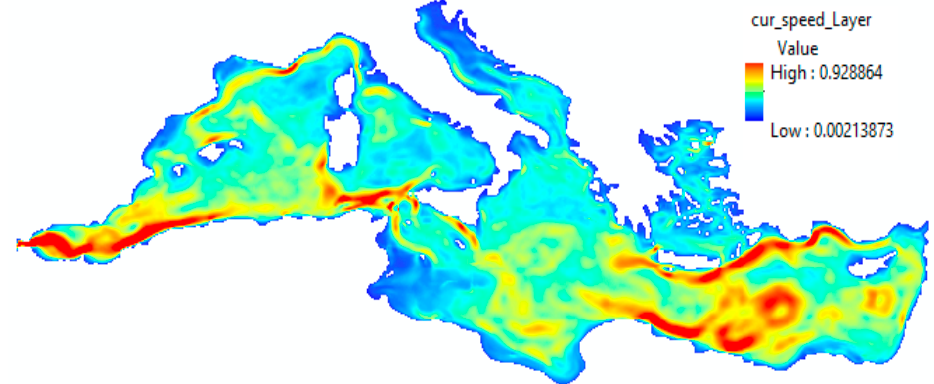
Figure 5. Sea current speed (SCS) (maximum speed over layer depth) averaged with 10 m height for the years from 2010 to 2015.